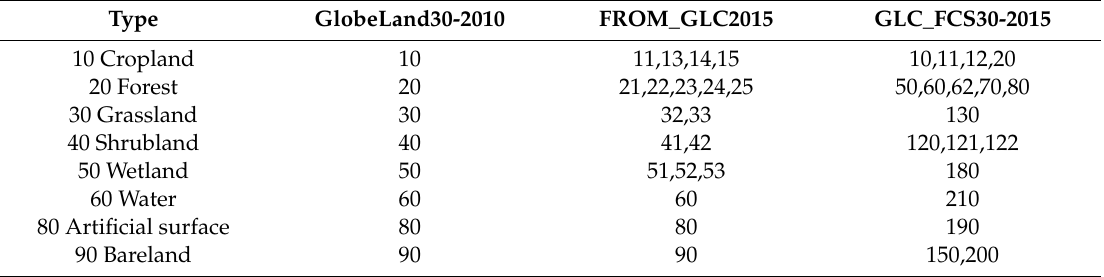
Table 3. Merged classification system and its correspondence with the original classification